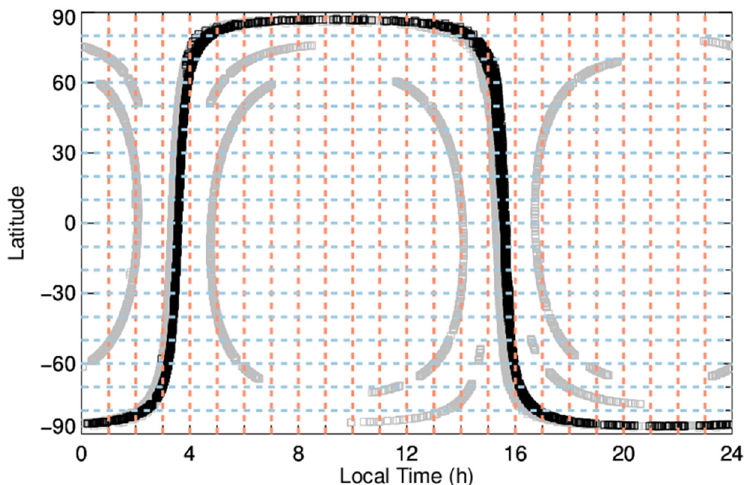
Figure 1. Latitude and local time coverage of the MCS observation. The blue boxes indicate the “in- track” observations in one orbit of MRO. The grey boxes indicate the multi-local time observational strategy, including the “cross-track” and “off-track” observations [40,41]. The blue horizontal dash lines show the latitude bin boundaries, while the red vertical dash lines show the local time bin boundaries of the data binning strategy used in this work.